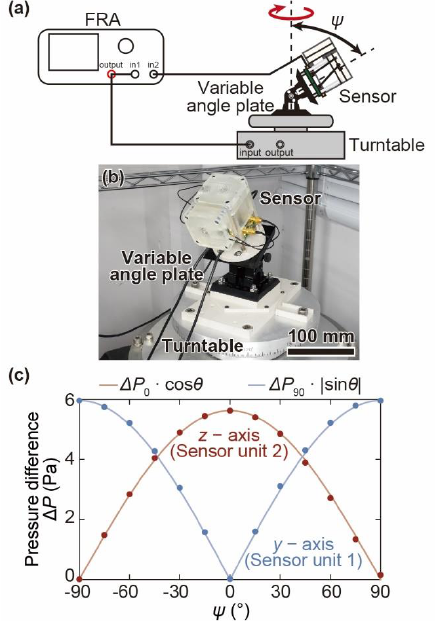
Figure 12. Measurement of biaxial angular acceleration. ( a ) Schematic image of the experimental setups for measuring the response of the sensor to angle, ( b ) photographs of the experimental setups when ψ = 30 ◦ , and ( c ) the relationship between the angle of the device and the differential pressure of the target axis. Each curve is a sinusoidal curve multiplied by the differential pressure applied to the cantilever by the angular acceleration around the target